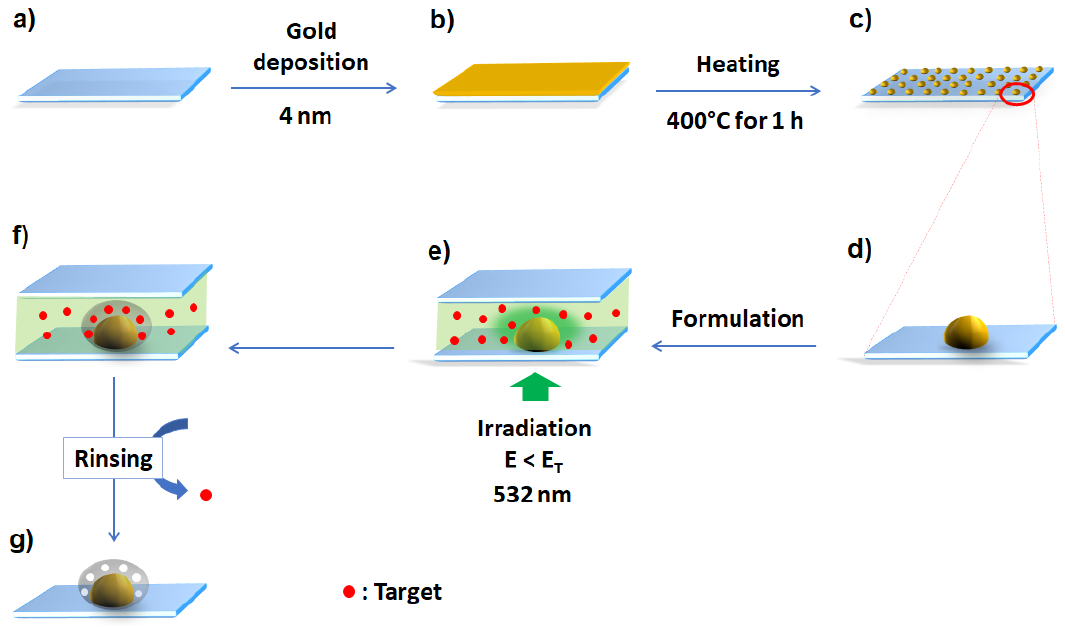
Figure 1. Protocol for the synthesis of AuNPs@MIP-R6G by NFP: ( a ): preparation of the glass slide, ( b ): deposition of a 4 nm gold film, ( c ): thermal dewetting at '400 °C for 1 h, ( d ): zoom on a nanoparticle, ( e ) deposition of the photopolymerizable MIP formulation and irradiation of the whole system at 532 nm, ( f ) synthesis of the AuNPs@MIP-R6G by localized photopolymerization, and ( g ) recognition sites are revealed after washing.